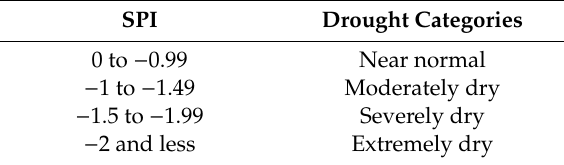
Table 1. Classification of drought events based on values of Standard Precipitation Index